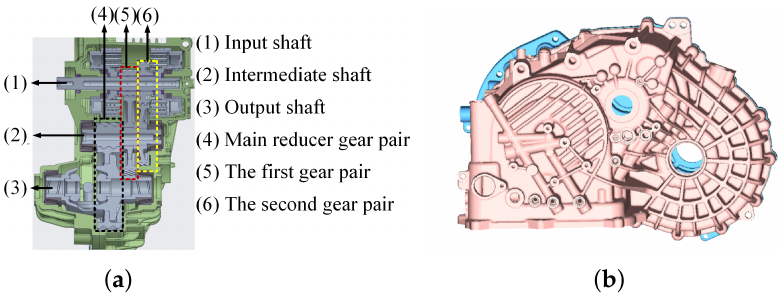
Figure 2. ( a ) Transmission 3D structure section view. ( b ) External structure of gearbox housing.